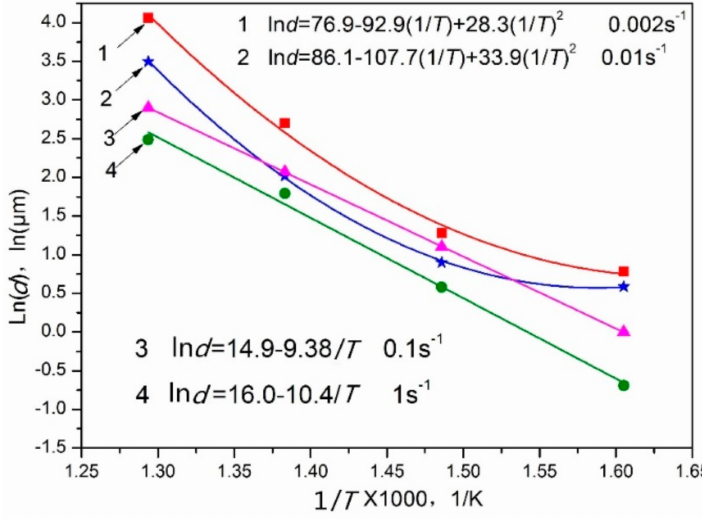
Figure 15. The relationships between ln d and 1/ T at different strain